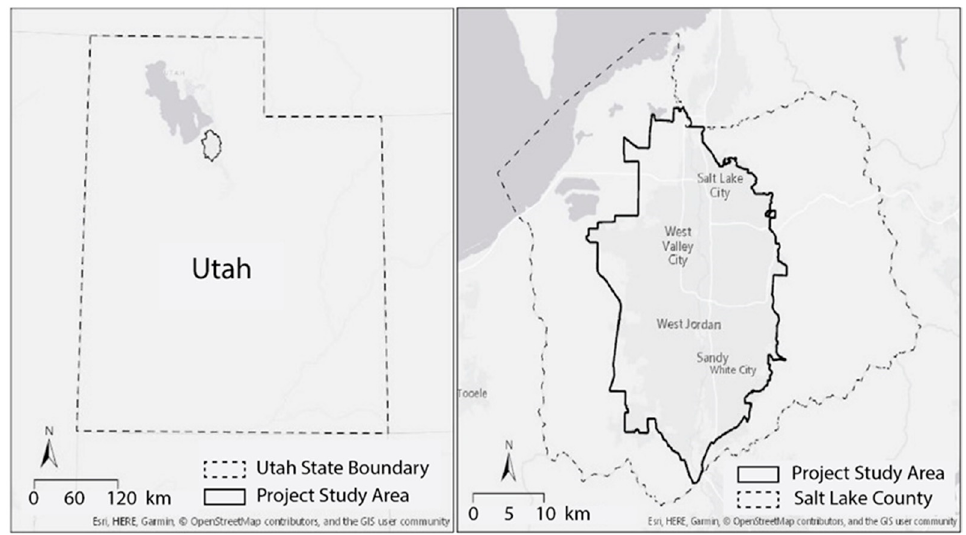
Figure 1. Study area in Salt Lake County, Utah, USA.